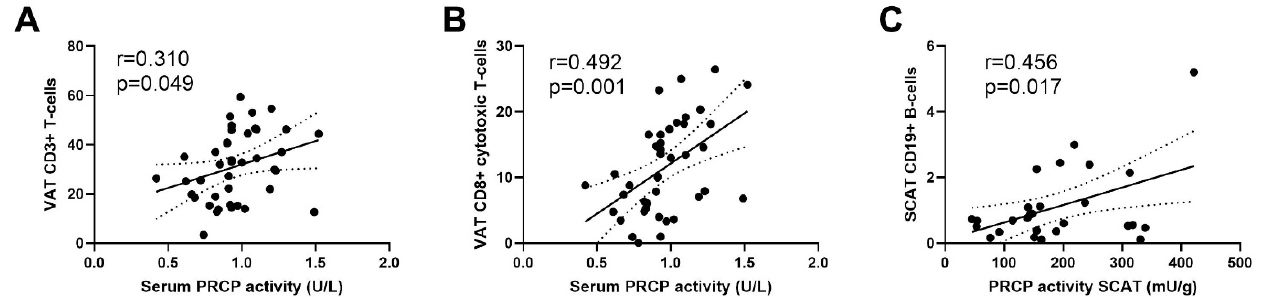
Figure 6. Correlation between serum PRCP activity and VAT CD3+ T-cells ( A ) and VAT CD8+ cytotoxic T-cells ( B ) and the correlation between PRCP activity in SCAT and SCAT CD19+ B-cells ( C ). Linear regression line is shown with 95% confidence interval. Circles: individual values; solid lines: Linear regression line; dotted line: 95% confidence interval for the regression line.